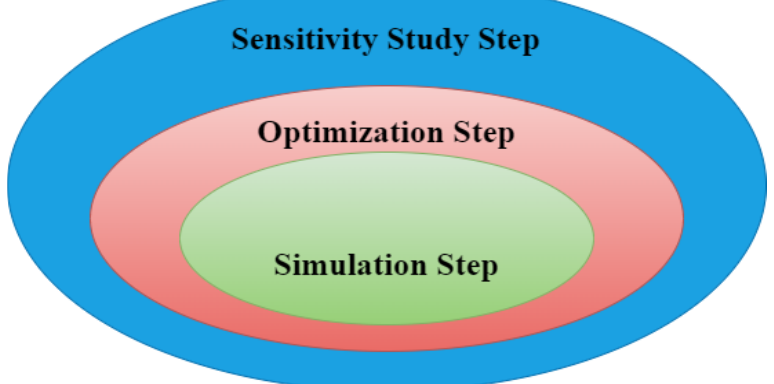
Figure 8. Three-step analysis carried out through